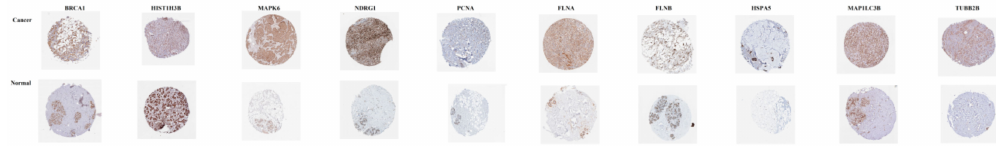
Figure 20. Box plots of hub genes ( FLNA , FLNB , HSPA5 , MAP1LC3B , and TUBB2B ). Red—high-risk; Green—low-risk.